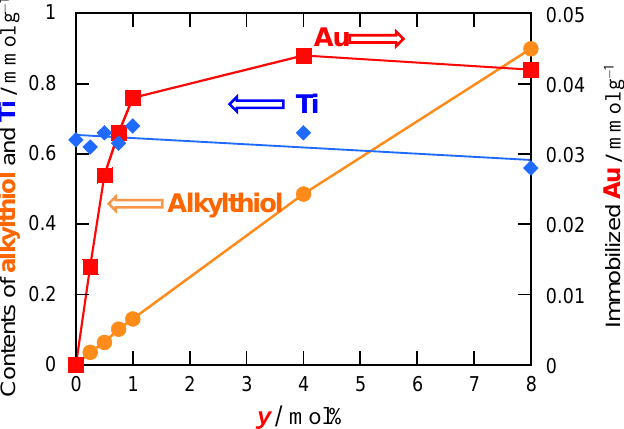
The immobilized amount of Au also depended on the amount of alkylthiol on the